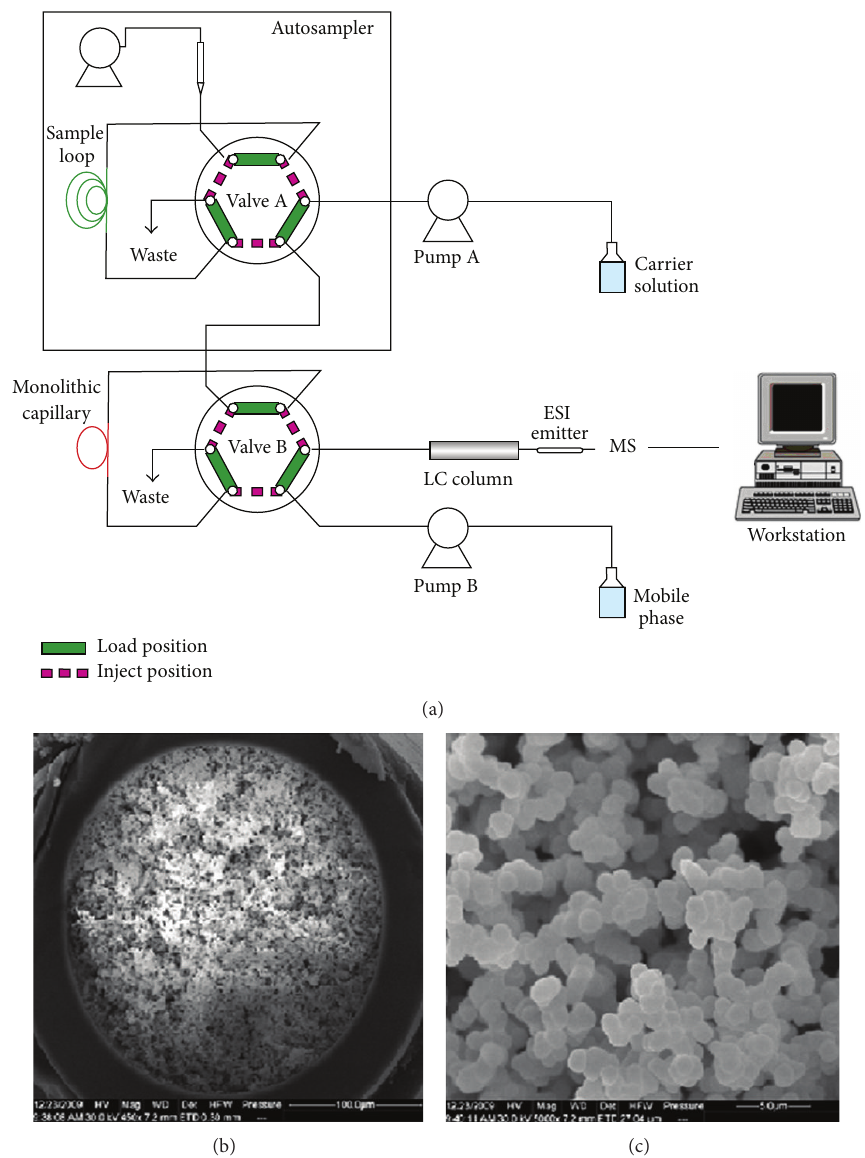
Figure 1: Construction of automated in-tube SPME-HPLC/MS system and Scanning electron microscope images of the cross section of the hybrid silica monolith: wide view (b) and close-up view (c)